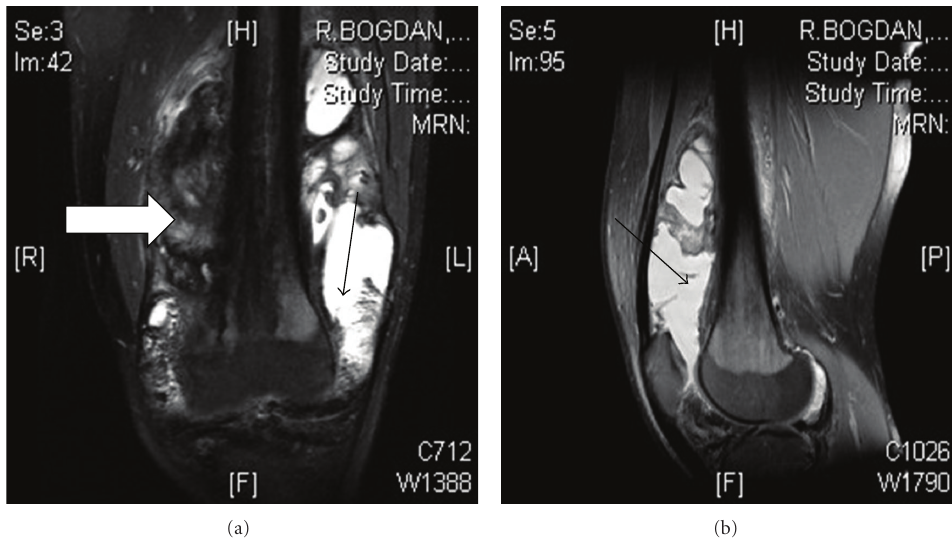
Figure 1: MRI of the knee joint of a 27-year-old haemophiliac. In the AP view (a) intra-articular blood can be noted in the lateral side of the joint (black arrow), while in the medial side a severe degree of synovitis can be seen (white arrow). In the lateral view of the MRI (b), the aforementioned hemarthrosis can also be noted (black